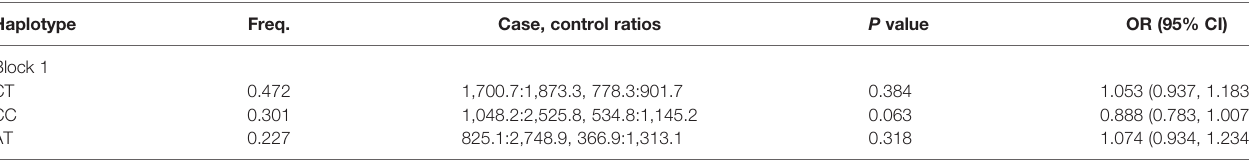
TABLE 4 | Haplotype analysis for two SNPs within Nox4 gene between CIB and healthy individuals by Haploview. Haplotype Freq.